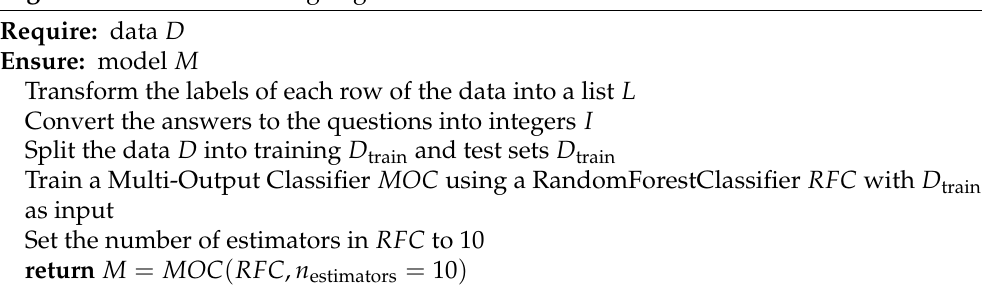
Algorithm 2 Model Learning